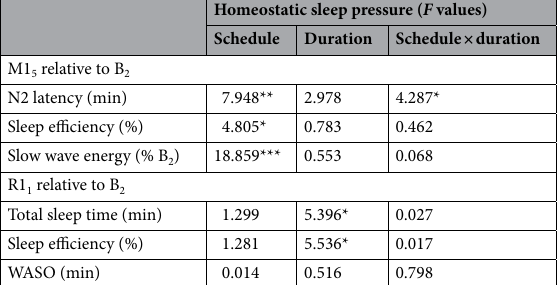
Table 2. Main and interaction effects of schedule (split/continuous) and duration (6.5 h/8 h) on metrics of homeostatic sleep pressure. WASO Wake after sleep onset. *** p < 0.001, ** p < 0.01, and * p <